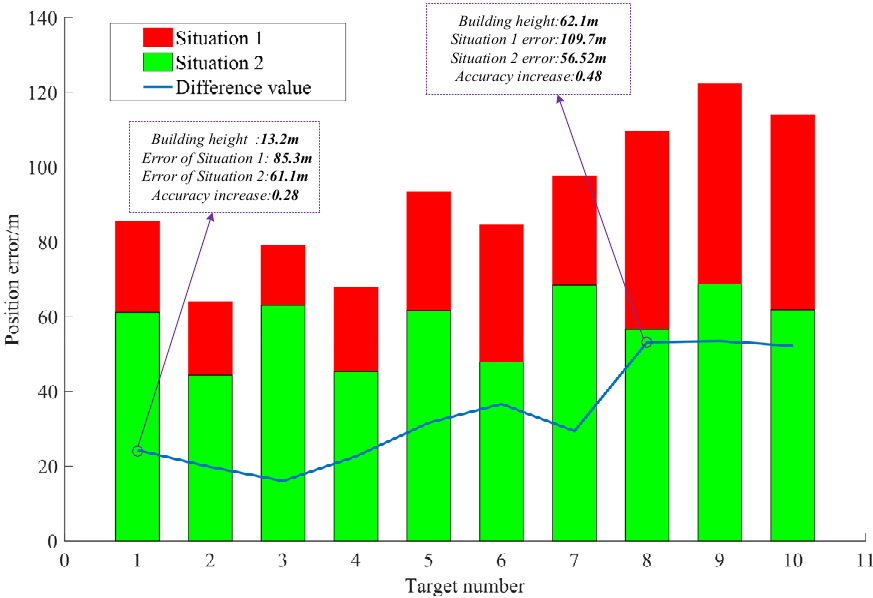
Figure 17. Comparison of positioning results.